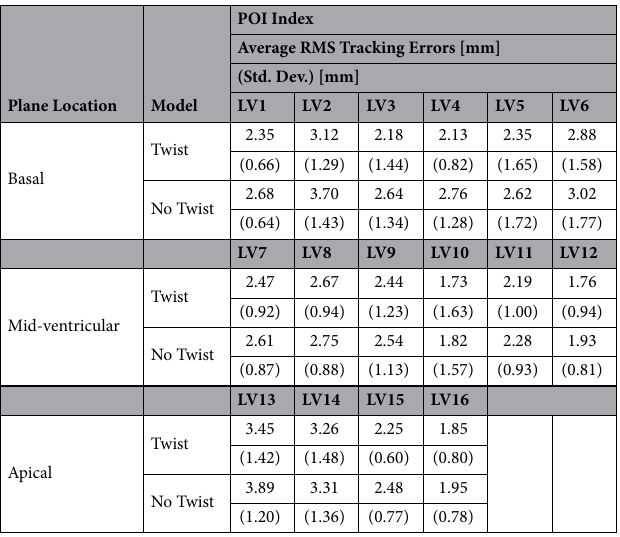
Table 4. The summary of the results for the 16-point LV epicardium model. The averages and standarddeviations of RMS tracking errors across the eight Cine MR Datasets are given. Results are shown with and without the twisting in the deformable